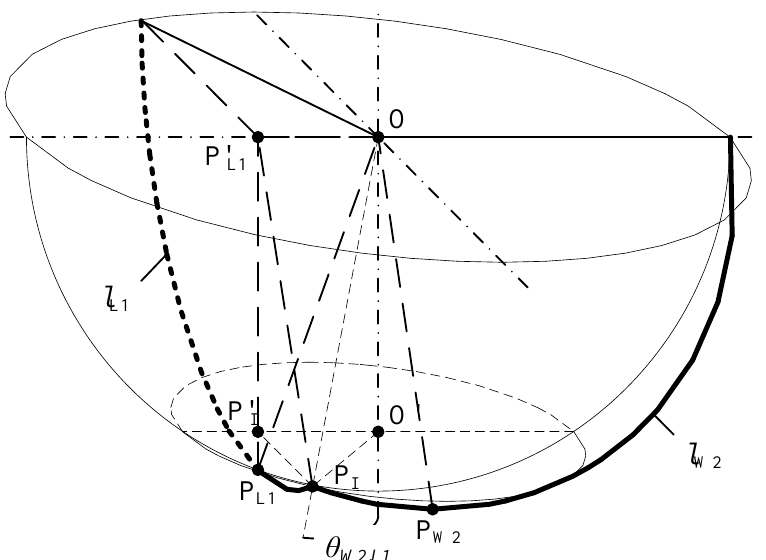
Figure A11. Ω L geometric sketch 1. Figure A11. Ω L geometric sketch